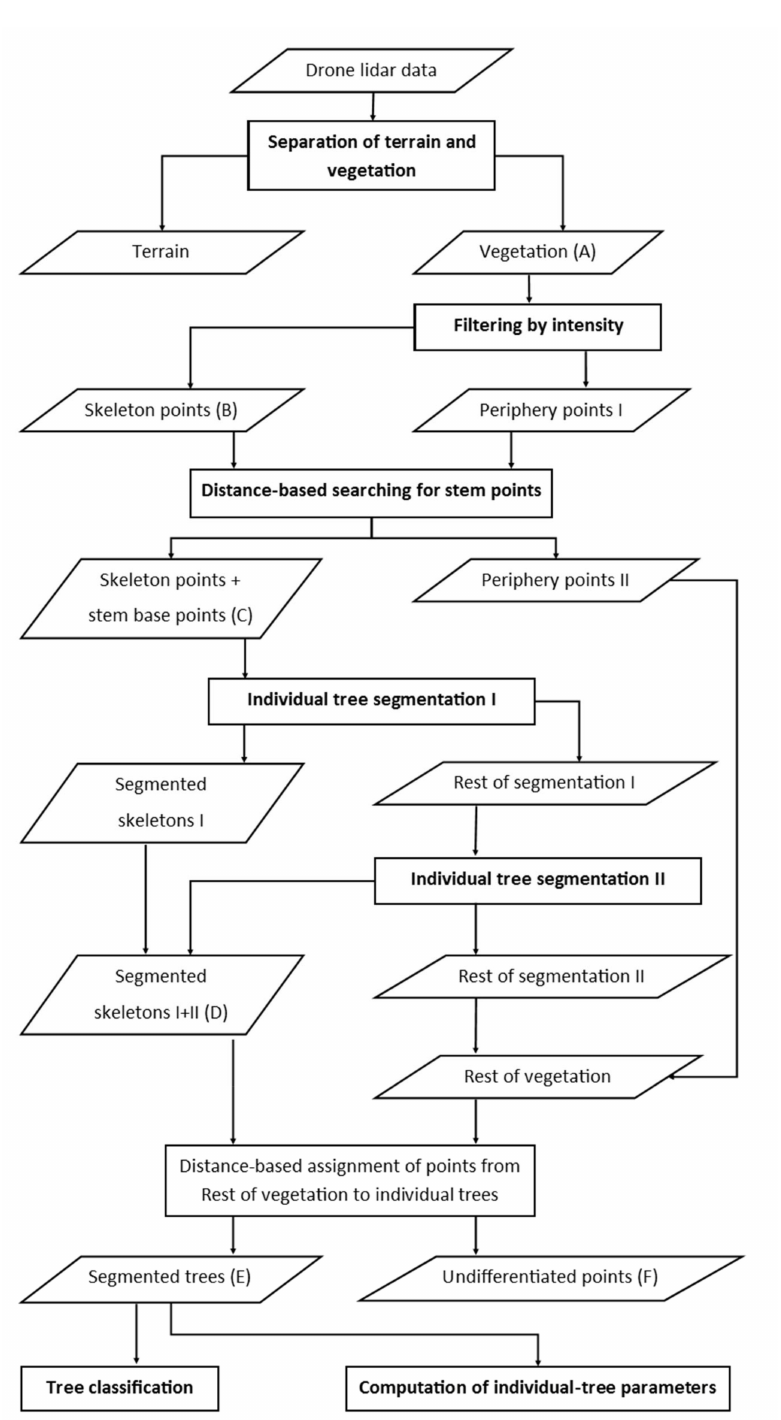
Figure 3. Workflow diagram for individual tree segmentation using ultra-high-density drone lidar. The capital letters in parentheses refer to the individual panels in Figure